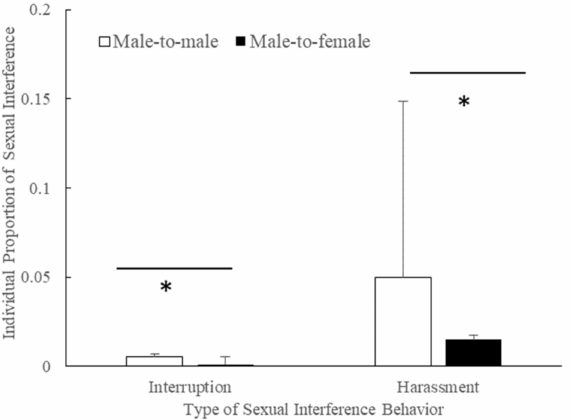
Figure 5. Interruption or harassment behaviors performed by adult and subadult males (Male-to- male indicates that the male harassed a mating male. Male-to-female indicates that the male harassed a mating female; *: p <